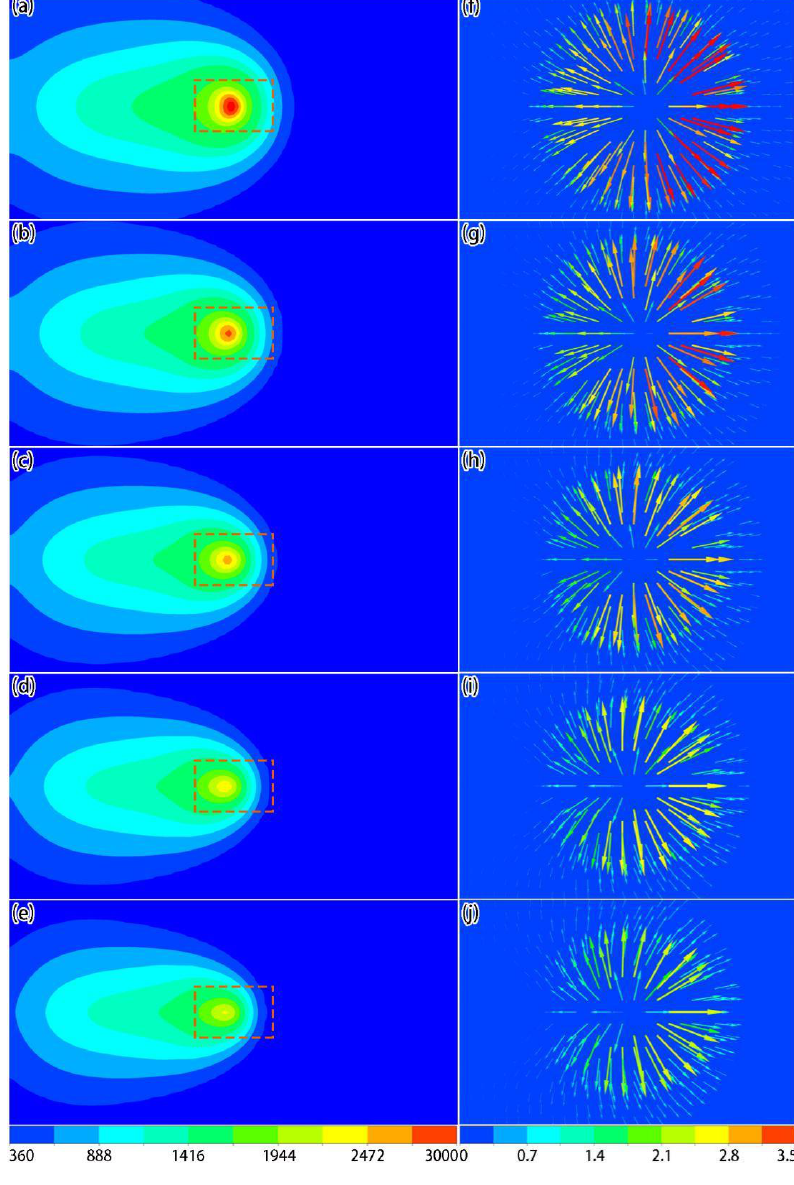
Figure 15. Simulation results of temperature ( a – e , unit: K) and local velocity ( f – j , unit: m/s) distributions on the surface under different scanning speeds when the laser acted on the center of the powder layer: ( a , f ) 0.4 m/s; ( b , g ) 0.5 m/s; ( c , h ) 0.6 m/s; ( d , i ) 0.7 m/s; ( e , j ) 0.8 m/s.